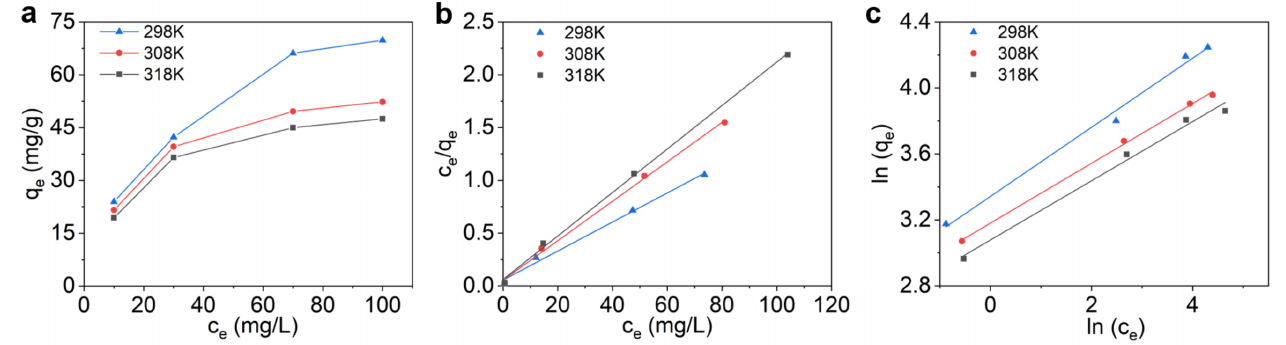
Figure 6. ( a ) The adsorption of different RhB concentrations by 20 mg BOI 2 /BMO at 298, 308, and 318 K. Linear ( b ) Langmuir and ( c ) Freundlich isotherm model